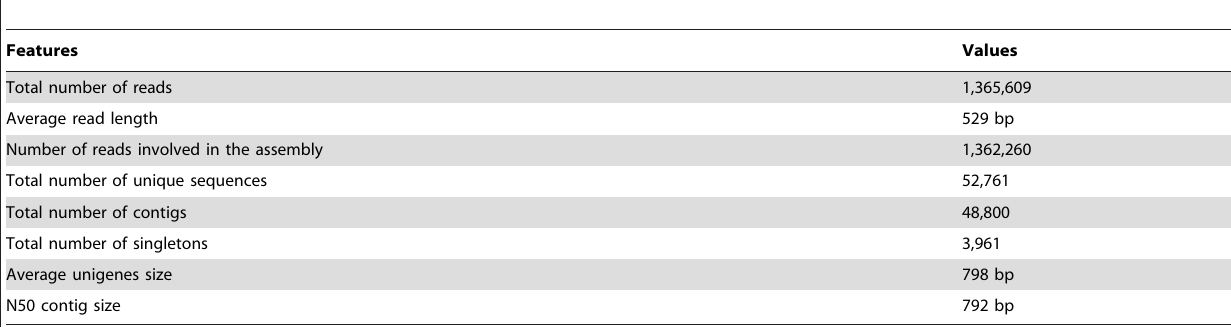
Table 1. Summary statistics of the ESTs generated from the German cockroach through pyrosequencing.